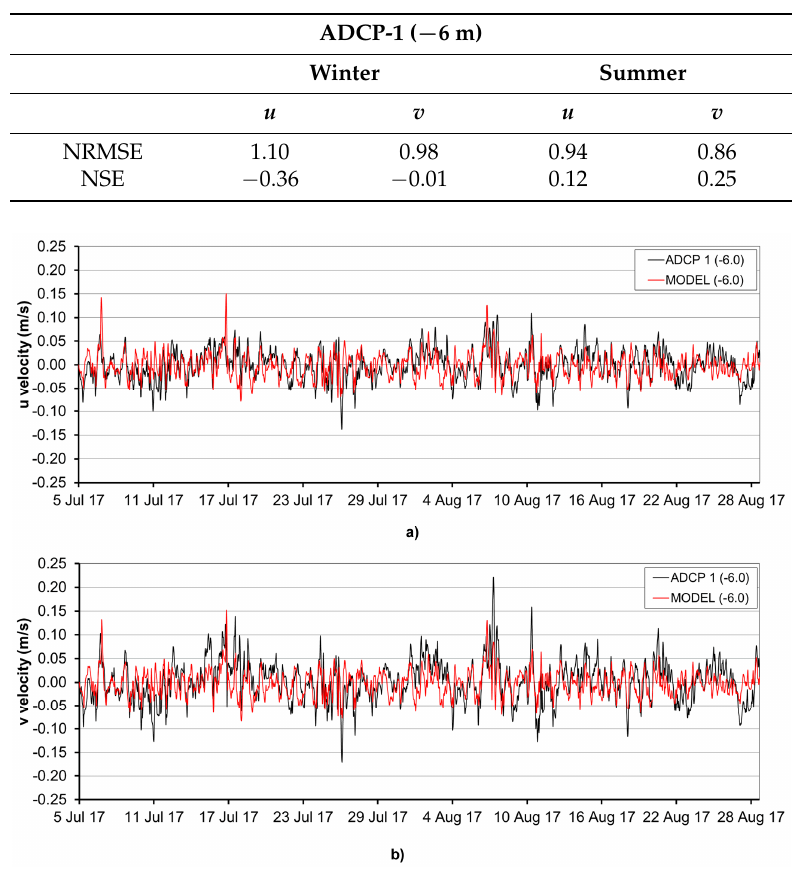
Figure 11. Comparison of measured and modeled hourly averaged ( a ) u velocity component and ( b ) v velocity component at a depth of − 6 m at the position of ADCP 1 for the summer period.